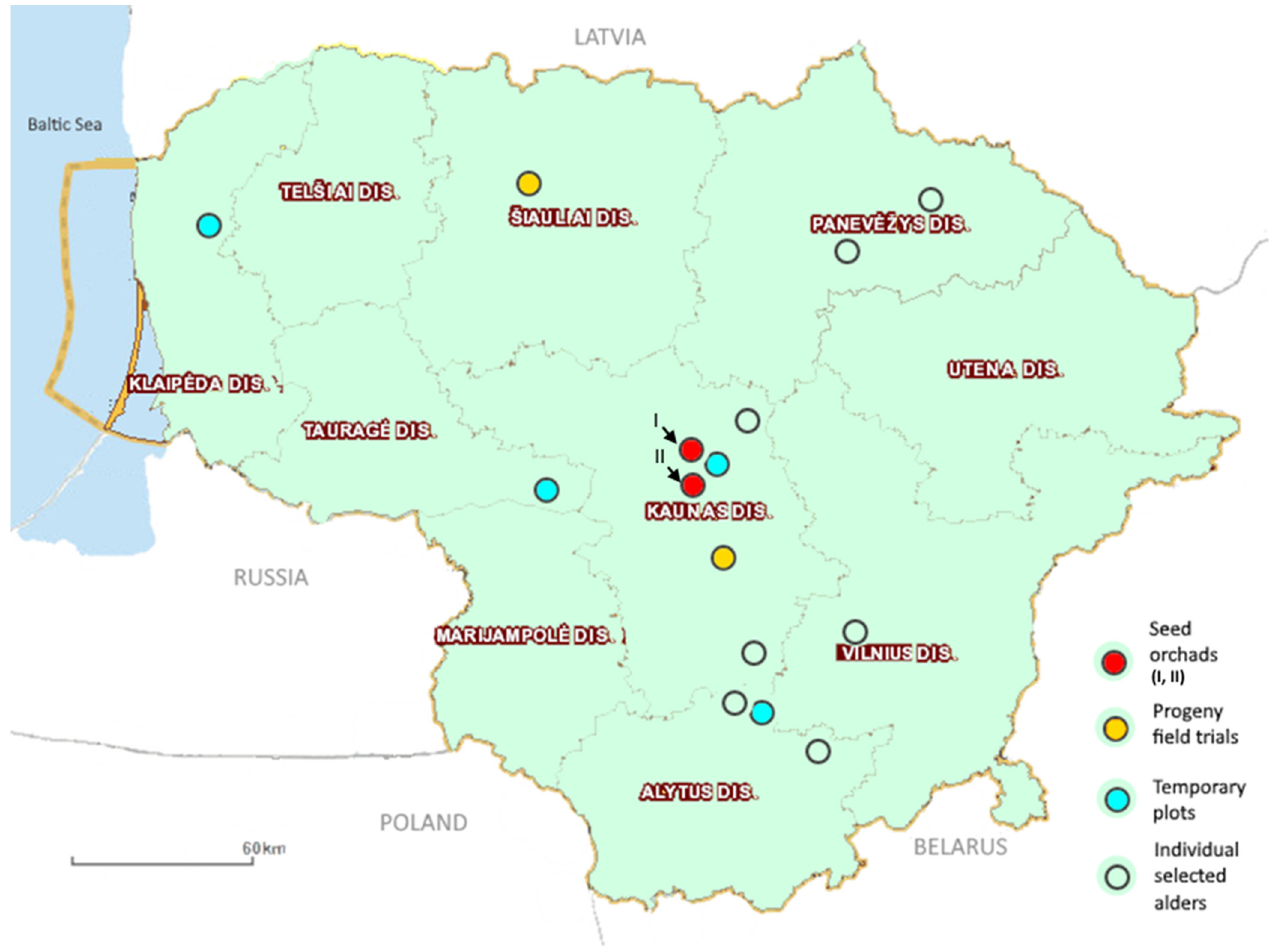
Figure 1. The leaf collection sites of alder species ( Alnus spp.) in Lithuania.